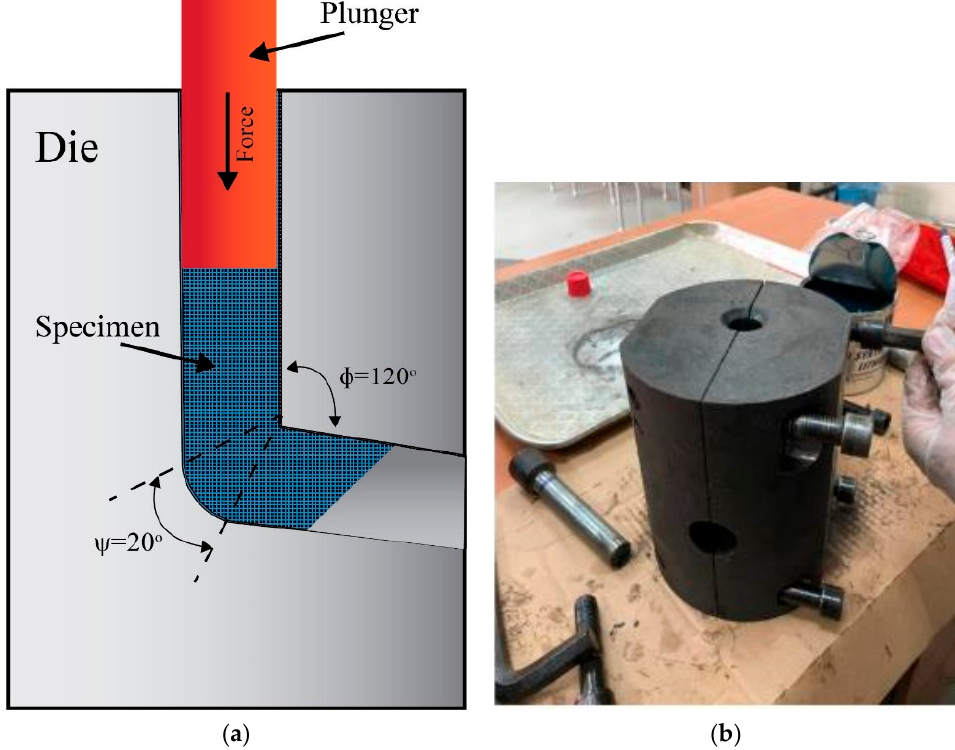
Figure 1. ( a ) Schematic of the right half ECAP die and ( b ) picture of the assembled die. The billets before and after the ECAP process were sectioned along the central longitudinal lines parallel and perpendicular to the extrusion direction, and then grinded and polished to a mirror-like surface. Vicker’s microhardness tests (HV) were conducted on the sample. Microhardness values were measured by taking readings following a rectilinear grid pattern with the spacing of 1 mm between each separate indentation starting at the billets’ peripheries and moving towards the center on sections that were cut near the top part of the ECAPed samples. This was conducted on both parallel and perpendicular sections to the extrusion direction to evaluate the hardness variation across the ECAPed rods’ longitudinal and transverse sections (LS and TS). The LS was of a square area with dimensions 20 × 20 mm 2 , whereas the TS was of a circular area with 20 mm diameter. Both the longitudinal and transverse sections were cut near the upper part of the